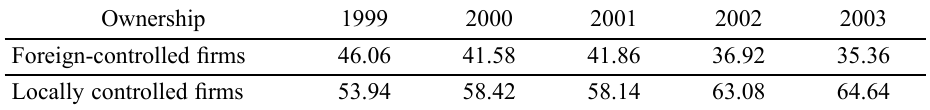
Table 6. Ownership structure of Singapore’s OFDI,